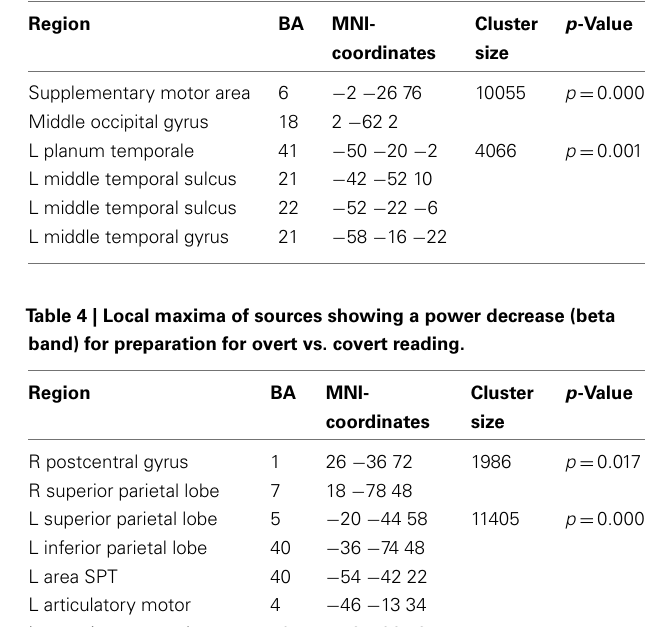
Table 3 | Local maxima of sources showing a power decrease (alpha band) for preparation for overt vs. covert reading.